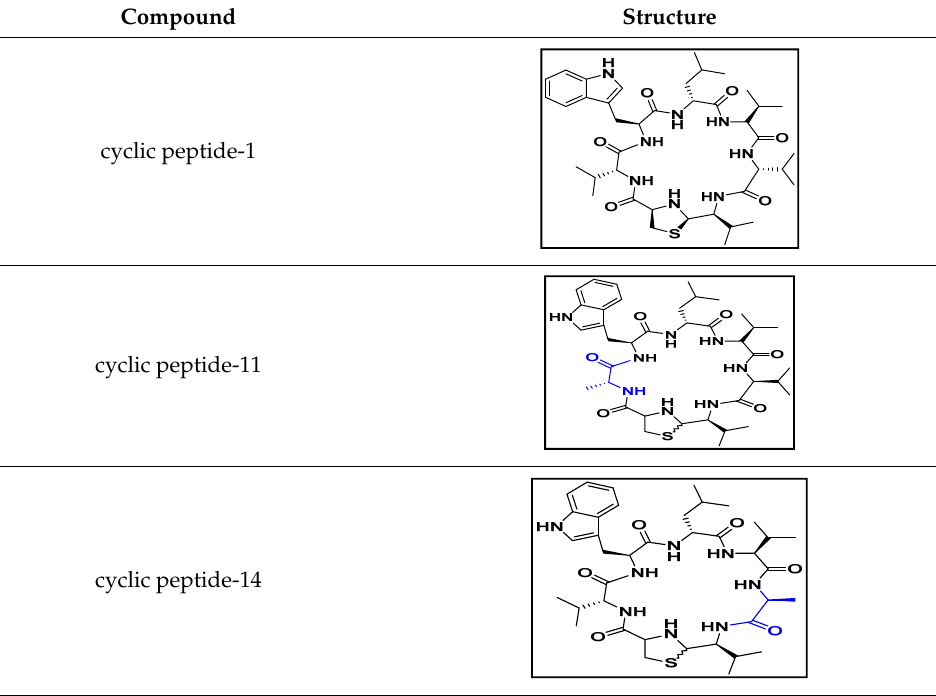
Table 4. Cyclic peptides used in the study.